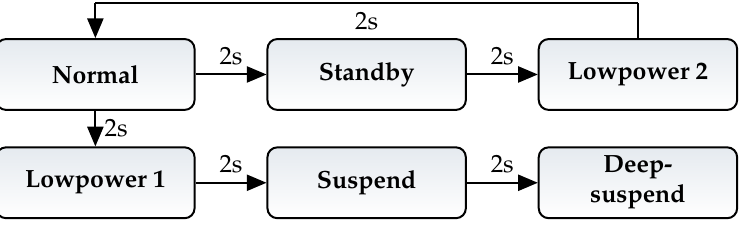
Figure 7. Control flow of accelerometer modes test.